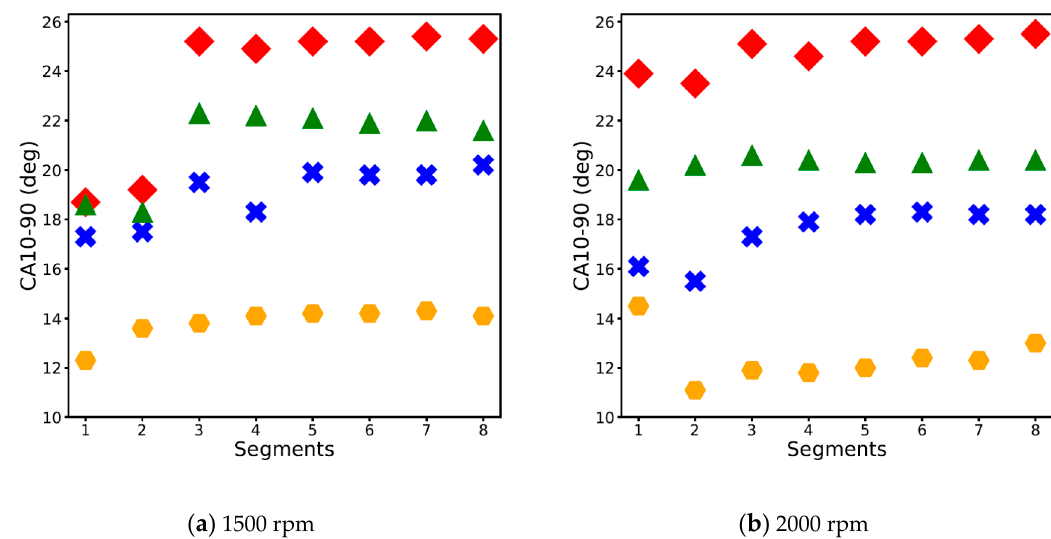
Figure 16. CA10–90 at all loads in each stage at ( a ) 1500 rpm and ( b ) 2000 rpm. The red thick diamond represents 100% load, the blue thick cross 50% load, the green triangle 75% load and the orange hexagon 25%